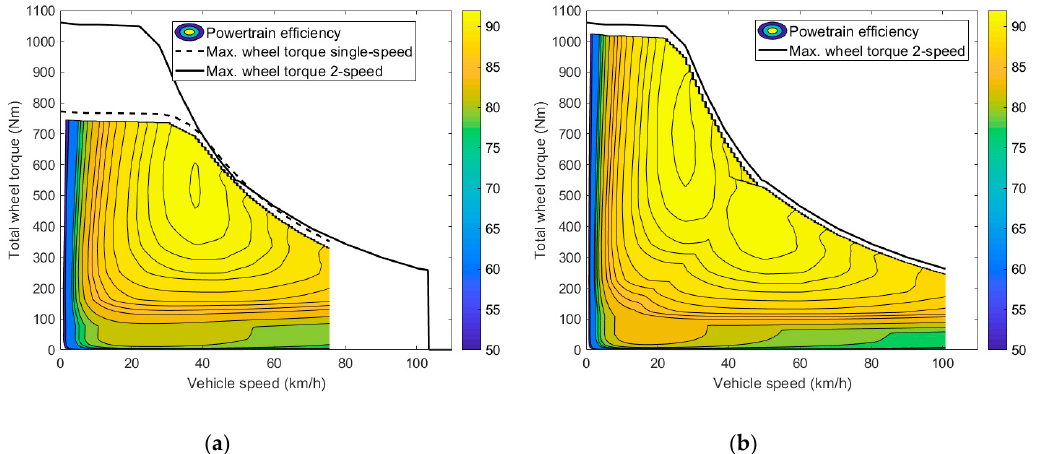
Figure3. E ffi ciencymapsoftheconsideredpowertrains, includingelectricmotordriveandtransmission: Figure 3. Efficiency maps of the considered powertrains, including electric motor drive and ( a ) Single-speed powertrain; ( b ) 2-speed powertrain (with optimal gear transmission: ( a ) Single-speed powertrain; ( b ) 2-speed powertrain (with optimal gear selection). Table 1. Main parameters of the considered EV layouts.